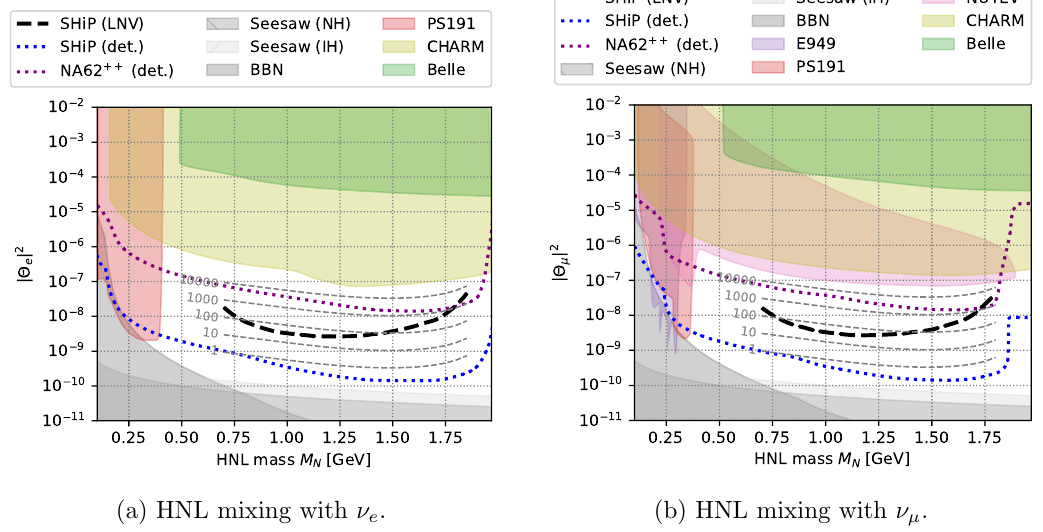
(a) HNL mixing with (cid:23) . (b) HNL mixing with (cid:23) . e (cid:22) Figure 10. SHiP sensitivity to lepton number violation. The thick dashed curve is the \model- selection" sensitivity computed in this work. The thin dashed grey lines show the number of fully reconstructible events which would be observed at SHiP for a given mass and mixing angle. Dotted curves are the (lower) detection sensitivities for the proposed or planned experiments which can reconstruct the HNL mass. Coloured, (cid:12)lled areas are regions of parameter space which have been excluded by previous experiments. The grey (cid:12)lled area denoted by BBN indicates the region which is incompatible with Big Bang Nucleosynthesis. Below the seesaw limit 10 (hatched region), mixing angles are too small to produce the observed neutrino